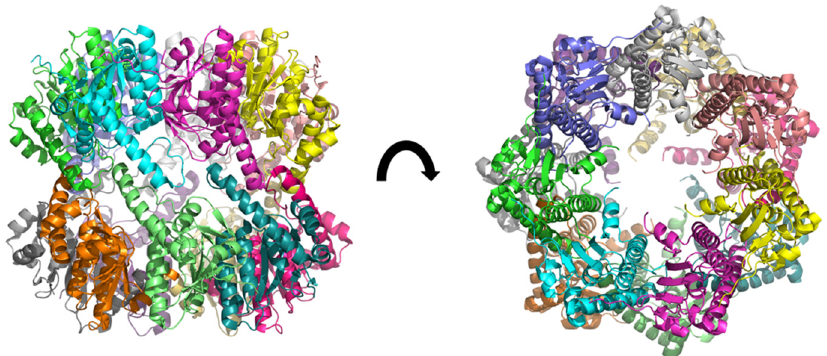
Figure 2. 3D structure of ClpP from Mycobacterium tuberculosis , determined by cryo-electromicroscopy at 3.10 Å of resolution (pdb ID: 6vgk) [28]. The fourteen subunits are shown in different colors. Two heptameric rings form a dimer resulting in a heptadecameric protein.